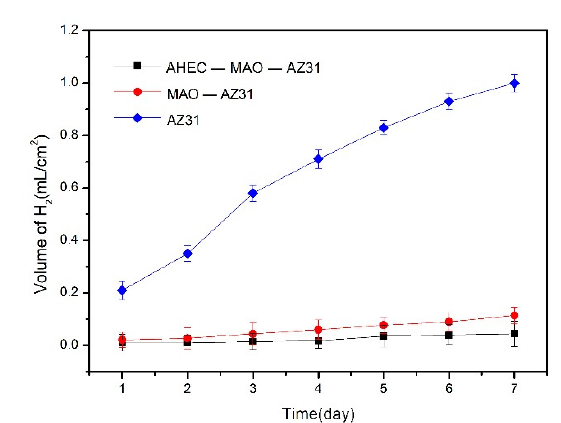
Figure 7. Volume of hydrogen released per unit area of AZ31, MAO + AZ31, and AHEC + MAO + AZ31 samples immersed at 37 °C for 7